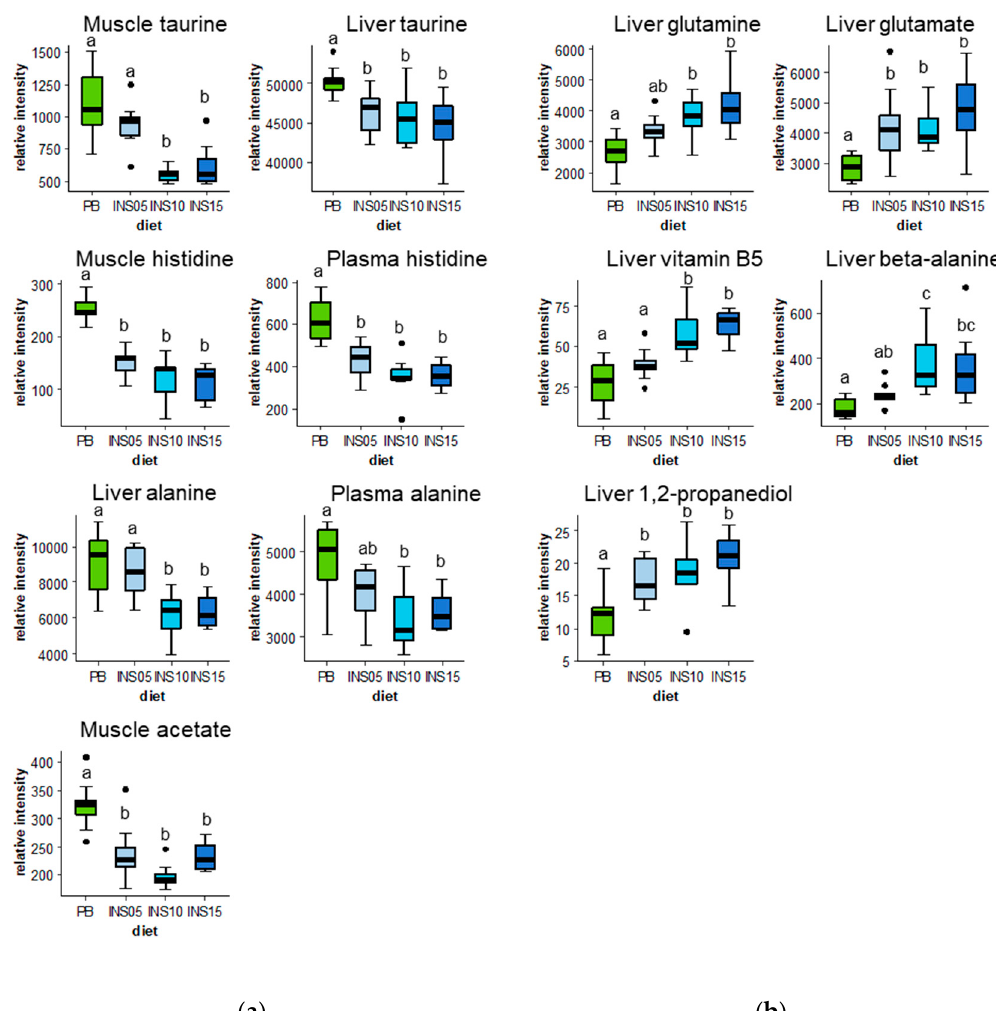
Figure 4. Whisker plots (n = 9 or 8) for 12 fish variables selected using OSC-PLS-DA presented in Figure 2 based on VIP score higher than 1.5 (Figure 3) for diet separation, and significantly affected by diet based on Kruskal-Wallis analysis ( P < 0.05). ( a ) Fish variables showing a decreasing trend with level of insect ingredient amount in diet. ( b ) Fish variables showing an increasing trend with level of insect ingredient amount in diet. For each plot, medians of diets were compared according to Dunn’s test ( P < 0.05): diets accompanied by the same letters (a, b or c) above their corresponding whisker plots were not significantly different according to Dunn’s test.